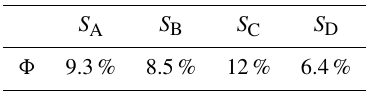
Table 6. Calculated skill scores, (cid:56) , for the four selection criteria A– D calculated using Eq. (10).